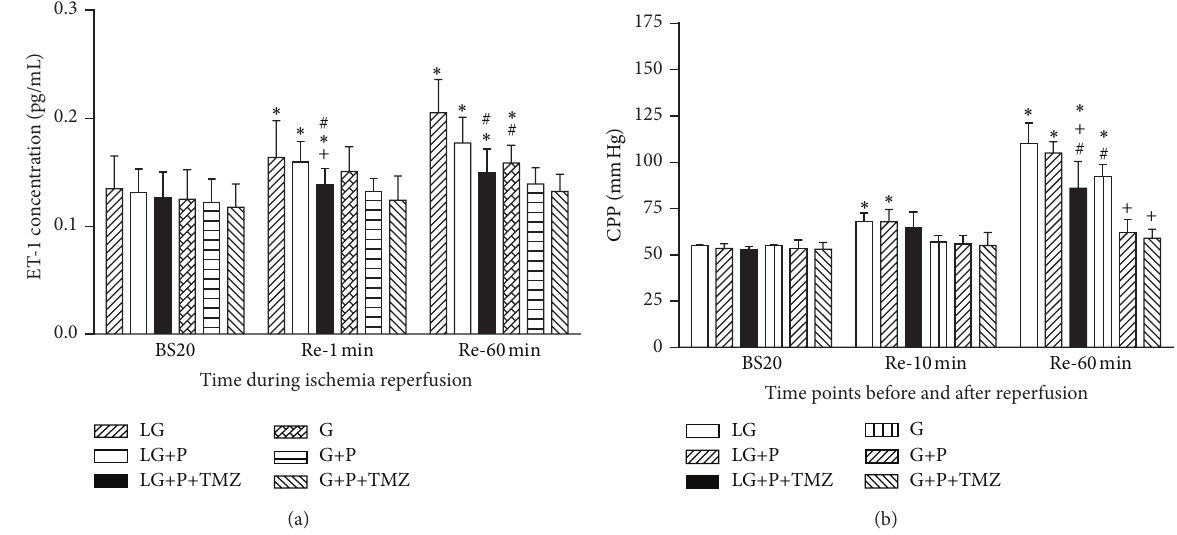
Figure 3: Effect of low glucose (LG) and glucose (G) on endothelin-1 (ET-1) concentration and coronary perfusion pressure (CPP). ET-1 release and CPP were significantly increased in LG as compared to G ( 𝑃 < 0.05 ). Propofol significantly reduced cardiac ET-1 and CPP in G but not in LG. TMZ facilitated propofol induced reduction in ET-1 and CPP in LG but did not in G. Re-10 is abbreviation of 10min after reperfusion. Values are presented as mean ± SEM. 𝑁 = 7 per group. ∗ 𝑃 < 0.05 versus BS20; # 𝑃 < 0.05 versus LG; + 𝑃 < 0.05 versus